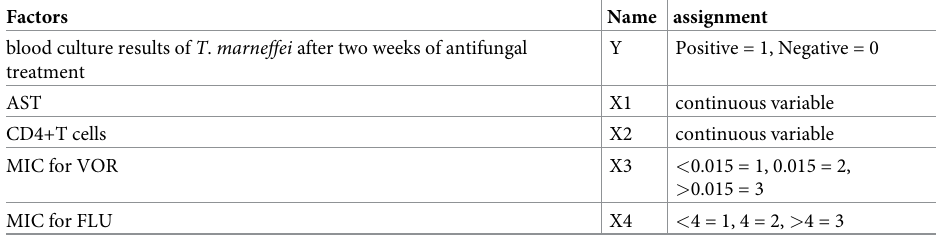
Table 3. Variable assignment included in regression analysis.